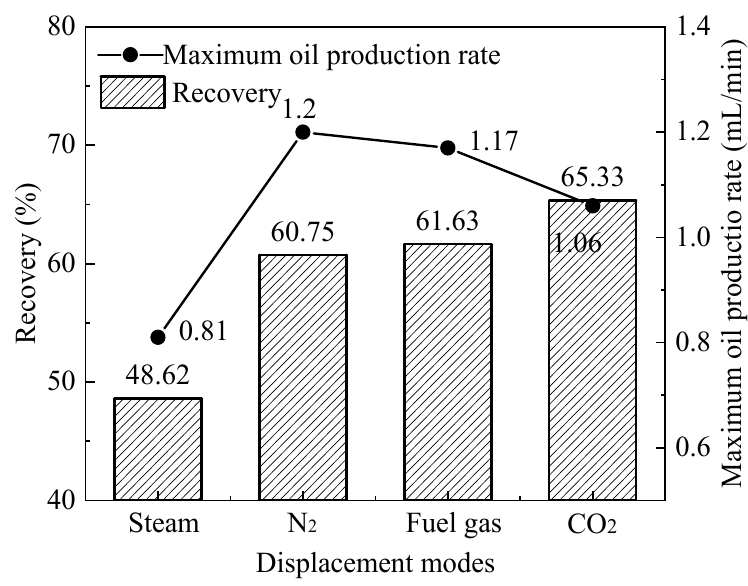
Figure 5. Maximum oil production rate and recovery under different displacement methods.